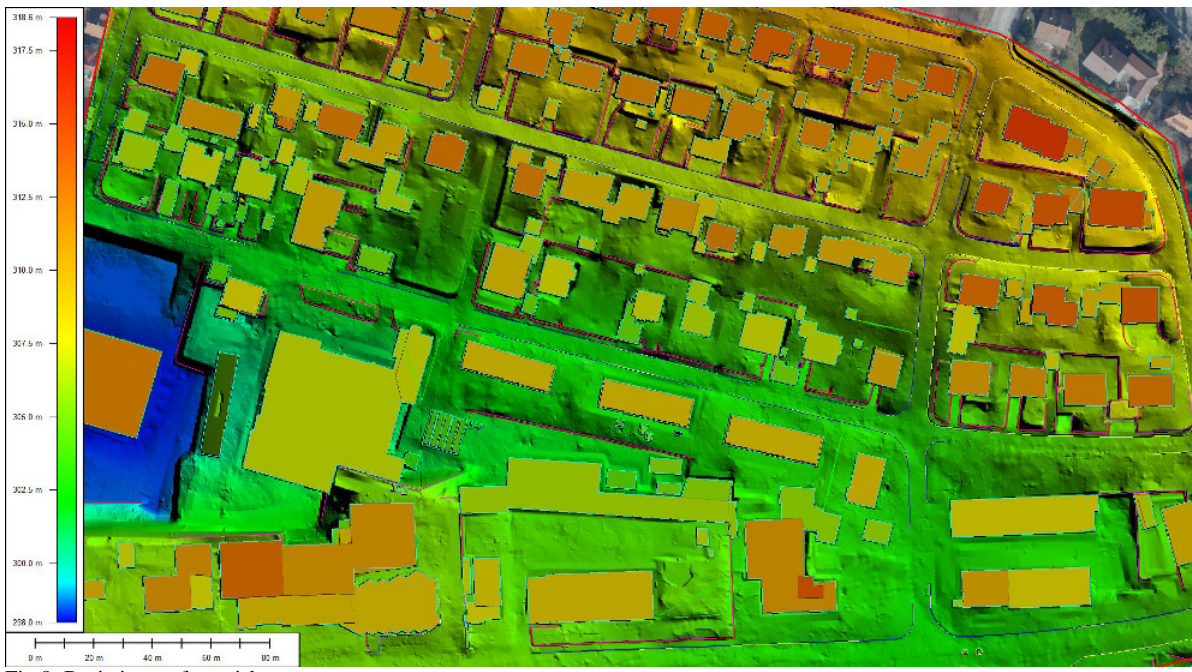
Fig 8: Basic image for a risk map A digital elevation model (DEM) was generated by a matching process of the aerial photographs. One can clearly see that the terrain in the upper part of the image (North) is higher, so the water will mainly flow from North to South. However, break lines were also measured. These show that the water is dammed at the upper light green east-west road and forced in certain directions. South of this road there are dark green areas which represent depressions and thus collect the